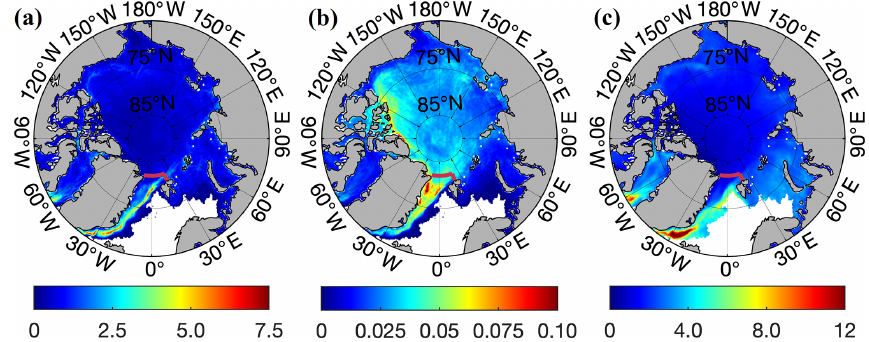
Figure 14. The mean ensemble standard deviation (SD) map of CMST (a) sea ice concentration (unit: %), (b) sea ice thickness (unit: m) and (c) sea ice drift (unit: kmd − 1 ) from September 2010 to December 2016. The thick red line represents zonal and meridional sea ice export gates to derive sea ice volume flux through the Fram Strait.